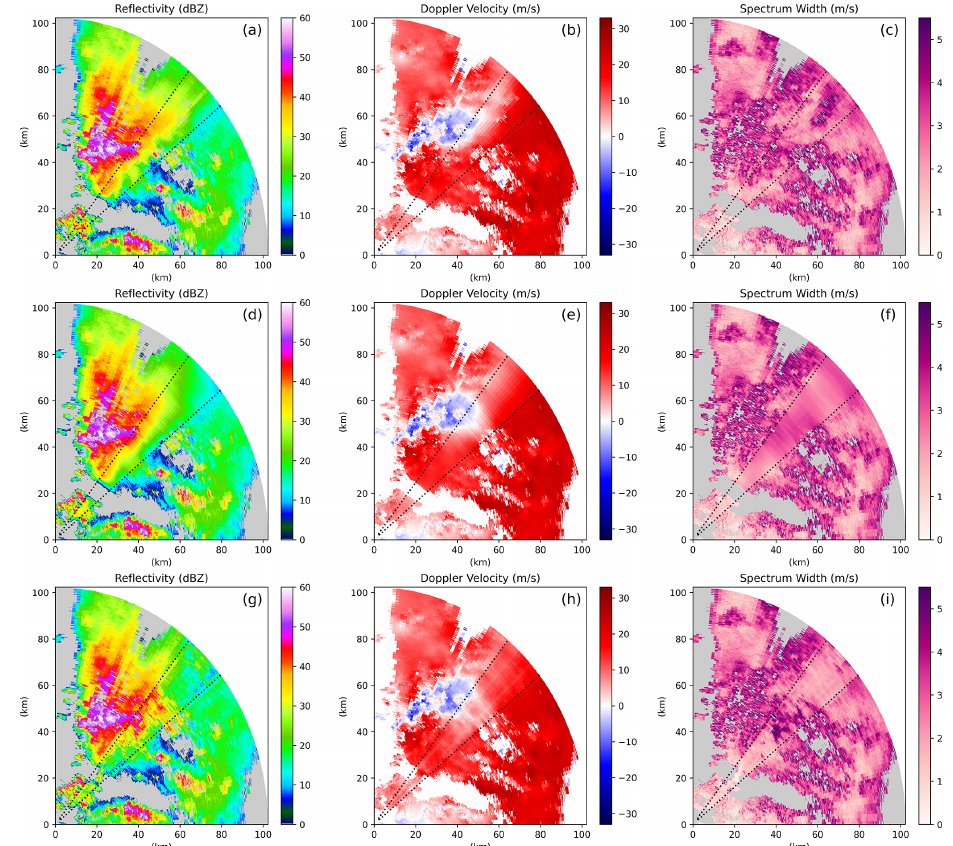
Figure 7. An example of inpainting a C-SAPR2 beam blockage. (a – c) Ground truth, (d – f) conventional CNN inpainting, and (g – i) CGAN